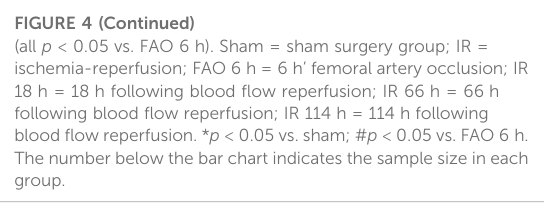
40 Hz). The re fl ex BP during muscle contraction was recorded in sham and IR rats. At the end of the experiments, the animals were euthanized by inhalation of an overdose of iso fl urane followed by cardiac puncture.